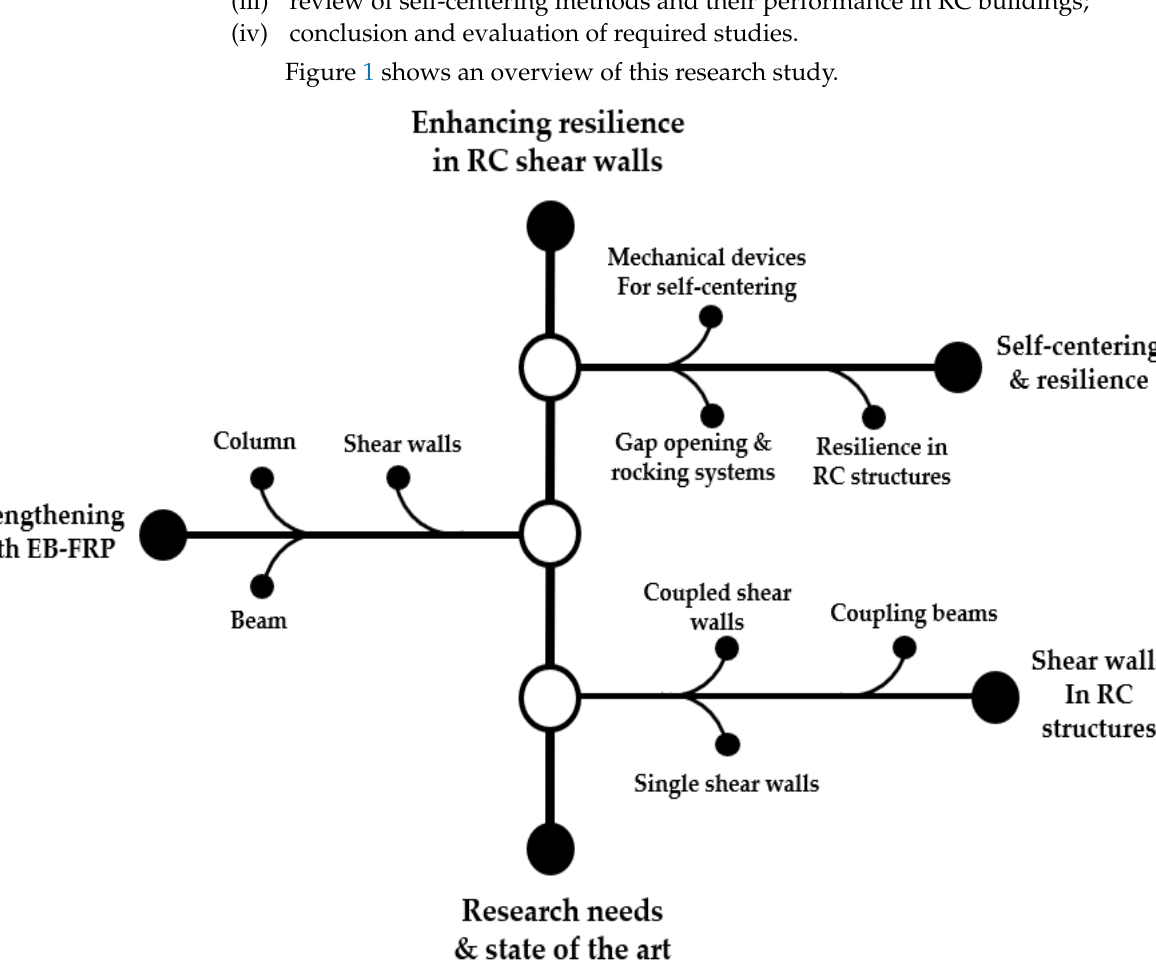
Figure 1. Overview of the present research